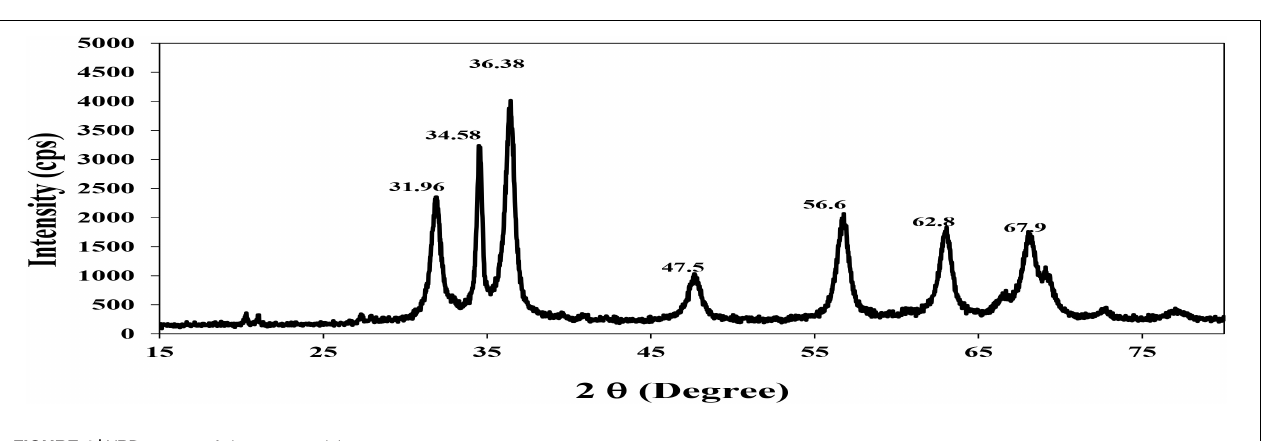
FIGURE 3 | FTIR spectra of zinc nanoparticles.